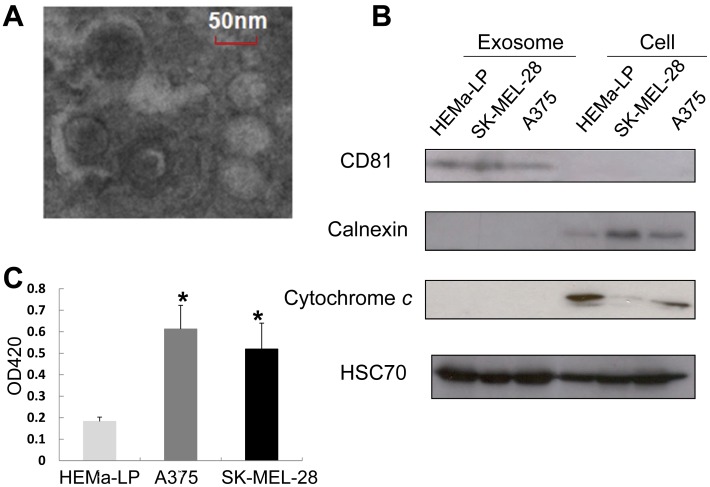
Identification and characterization of exosomes.Exosomes were isolated using a combination of ultrafiltration and ultracentrifugation. (A). Morphological characterization of exosomes derived from A375 cells by transmission electron microscopy. The image shows small vesicles ranging in size from 50 nm–100 nm in diameter. The scale bar indicates 50 nm. (B). Molecular characterization of exosomes derived from HEMa-LP, SK-MEL-28 and A375 cells by Western blotting. Protein extracts (50 µg) from cells or exosomes were assessed using antibodies against exosomal protein marker (CD81), endoplasmic reticulum marker (Calnexin), and mitochondrial protein marker (cytochrome c). HSC70, a protein expressed both in cells and exosomes, was used as a loading control. (C) Isolated exosomes from an average of 500 ml supernatant of HEMa-LP cells, SK-MEL-28 cells and A375 cells were resuspended in 100 µl of PBS and their quantities were determined using a Nanodrop ND-1000 spectrophotometer reading at OD420.